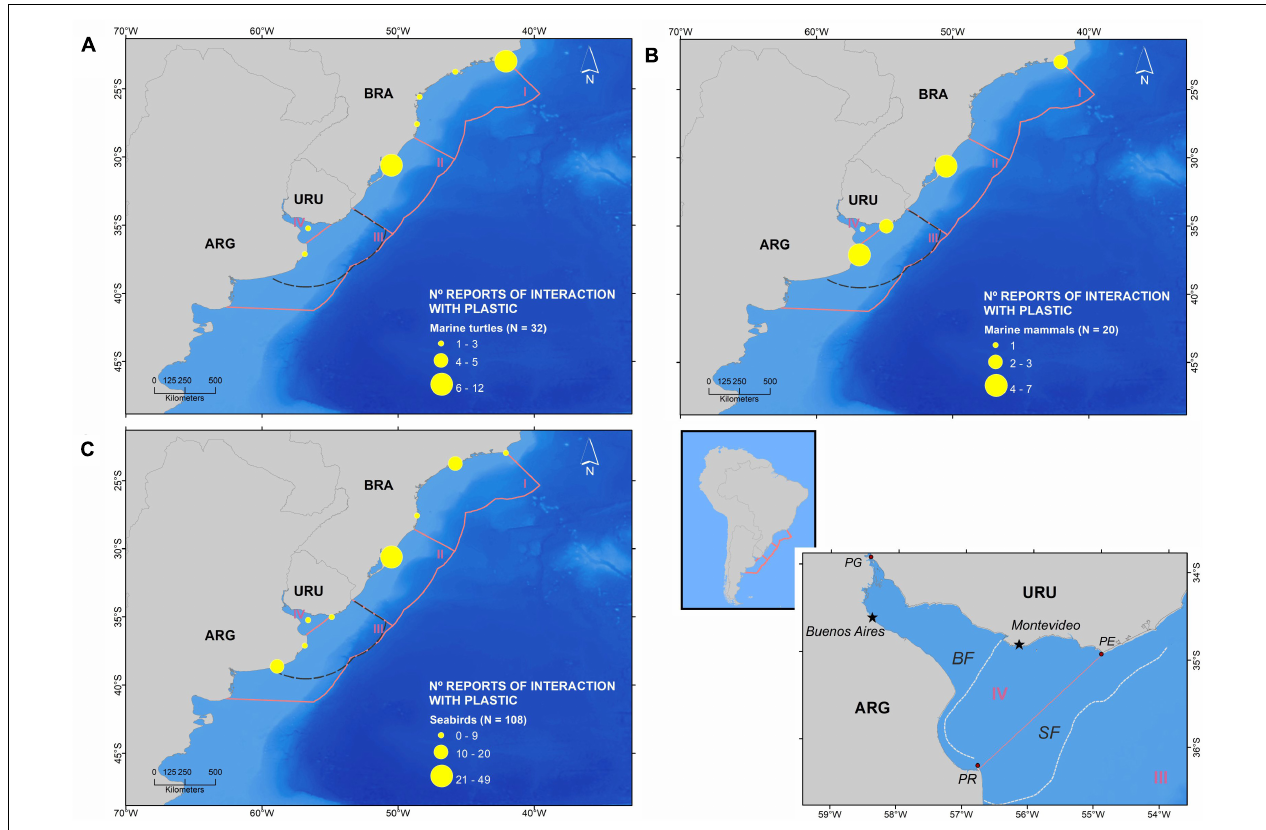
FIGURE 1 | Distribution of reports on the interaction of charismatic species of (A) marine turtles, (B) mammals, and (C) seabirds with plastics in the Warm Temperate Southwest Atlantic. Ecoregions within the study area are denoted with pink line and numbers: I, Southeastern Brazil; II, Rio Grande; III, Uruguay-Buenos Aires Shelf; and IV, Río de la Plata. Gray dashed line indicates the area of action of the Río de la Plata Bilateral Treaty. White-dashed lines denote the Río de la Plata bottom (BF) and surface (SF) frontal system. BRA, Brazil; URU, Uruguay; ARG, Argentina; PG, Punta Gorda; PR, Punta Rasa; PE, Punta del